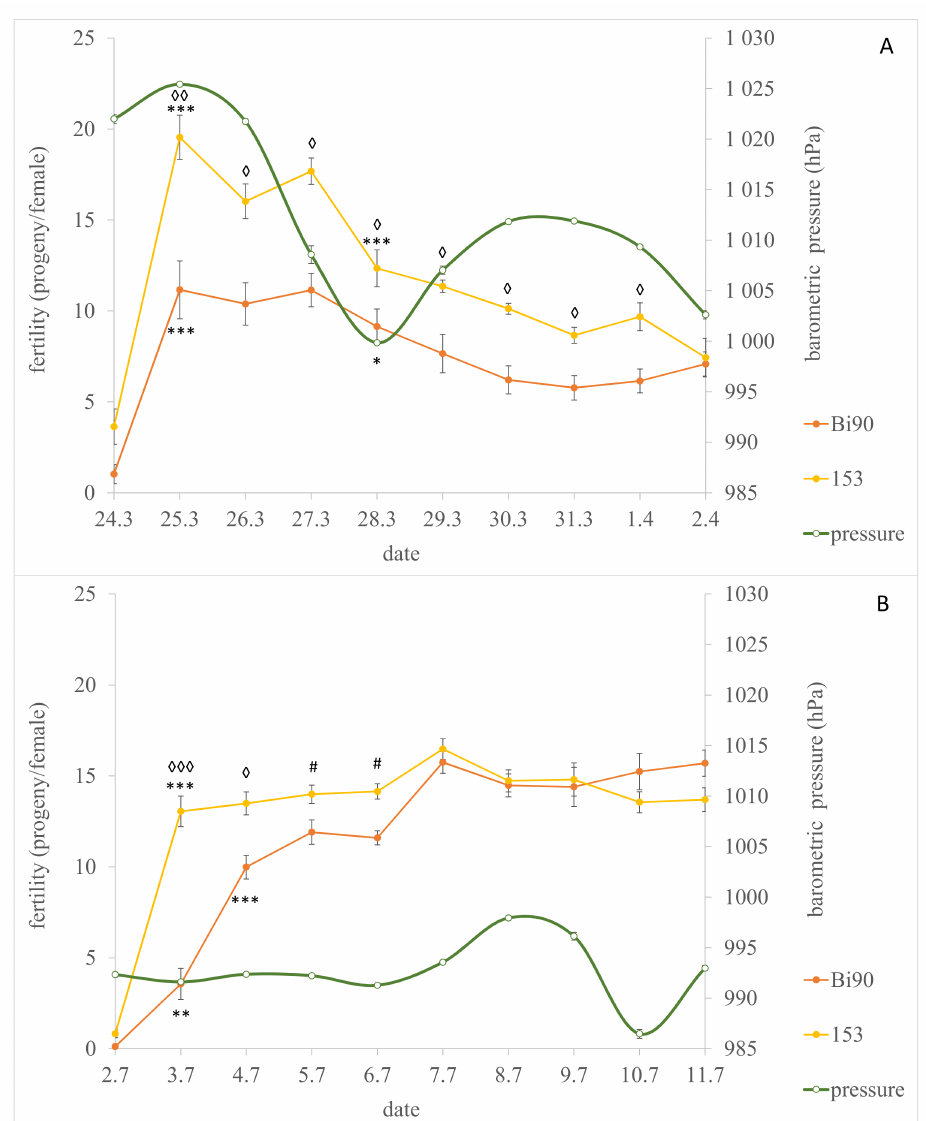
Figure 1. The fertility of D. melanogaster wild type strains Bi90 and 153 in comparison with variations of barometric pressure in Novosibirsk, Russia, in the end of March ( A ) and beginning of July ( B ) of 2020 (https://www.wunderground.com/history, (accessed on 10 September 2021)). Each point represents an average value of 10 tests (N = 5 for each test) as means ± s.e.m. The diamonds and hashtags indicate post-hoc differences between fertility levels of Bi90 and 153 flies on the same day; the asterisks illustrate the post-hoc differences in comparison with the fertility level of the same line on previous day. One diamond or asterisk indicates p < 0.05; two diamonds or asterisks, p < 0.01; three— p < 0.001, one hashtag indicates tendency to differences— p <